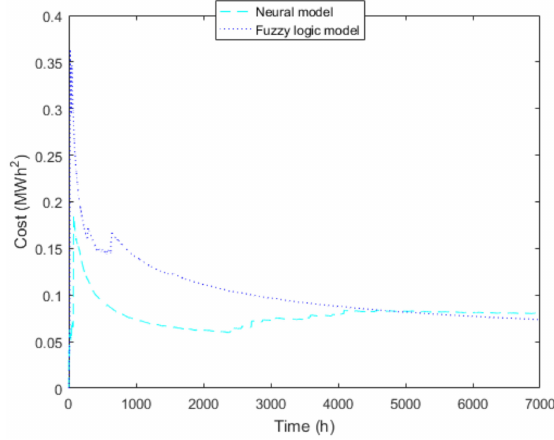
Figure 9. Training costs of the second training dataset.